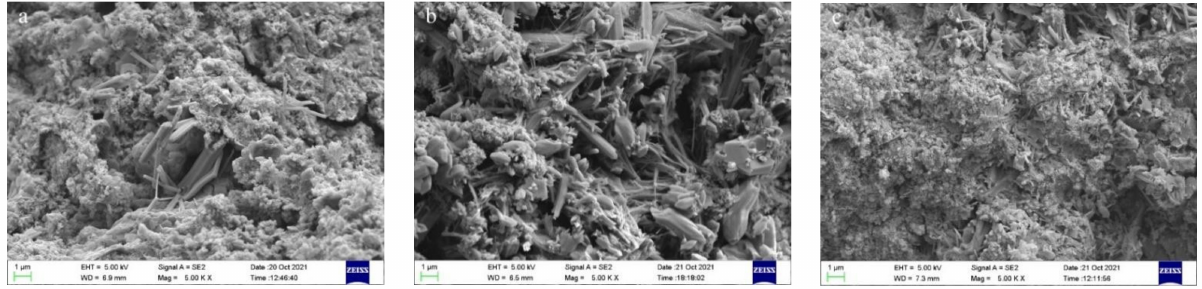
Figure 10. SEM images of non-fired bricks with different mixing-water amounts: ( a ) 10%; ( b ) 14%; ( c )